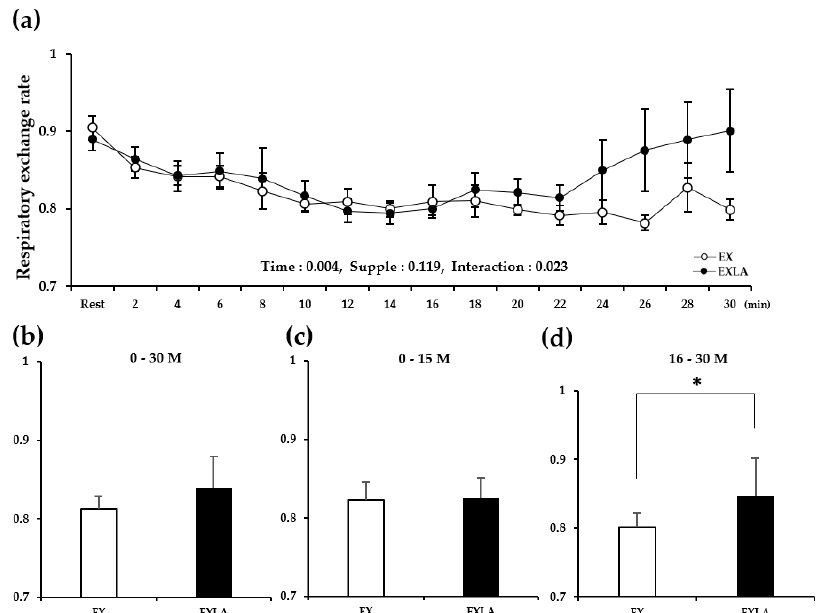
Figure 3. Changes in RER during exercise. ( a ) RER changes over time for 30 min; ( b ) average RER for 30 min; ( c , d ) average RER for 0–15 min (0–15 M) and 16–30 min (16–30 M), respectively. Supple, supplement effect; Inter, interaction effect; RER, respiratory exchange rate; EX, exercise control group; EXLA, exercise with lactate intake group. Values represent the mean ± standard deviation ( n = 8). * p < 0.05.